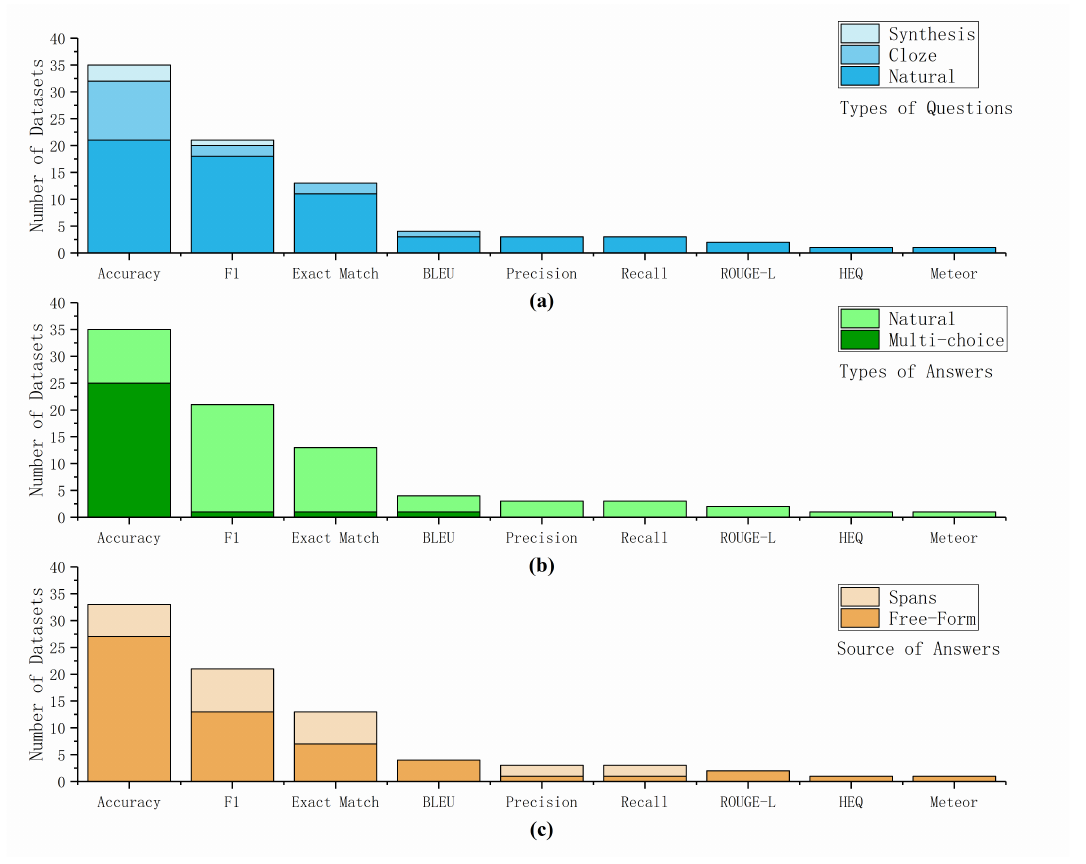
Figure 20. The usage of evaluation metrics with different types of MRC tasks: ( a ) The MRC tasks are classified according to the type of questions. Dark blue indicates that the question type is natural, blue represents that the question type is cloze, and light blue represents that the question type is synthetic. ( b ) The MRC tasks are classified according to the type of answers. Dark green indicates that the answer type is natural, and light green represents that the answer type is multi-choice. ( c ) The MRC tasks are classified according to the source of answers. Dark orange indicates that the answer source is free-form, and light red represents that the answer source is